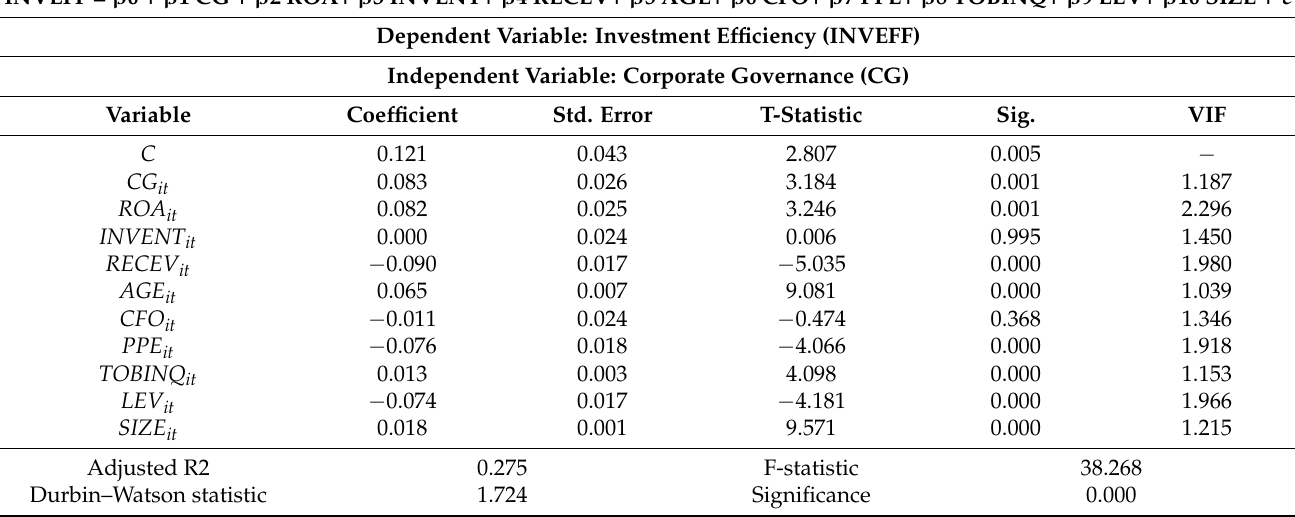
Table 8. Results of the statistical test of the first